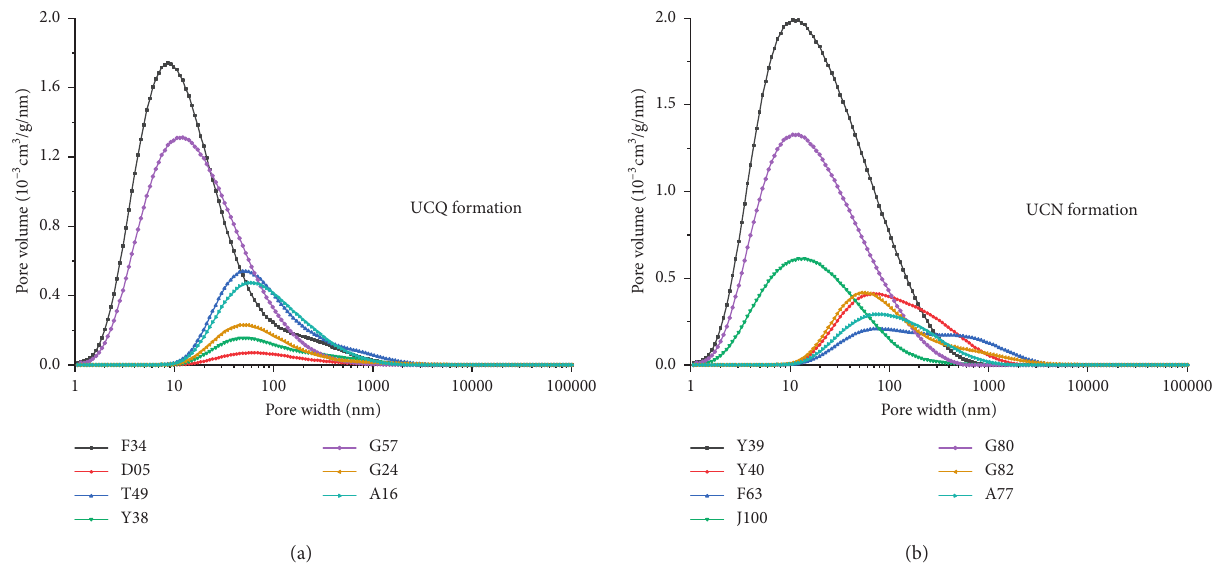
Figure 8: Pore size distribution based on low-temperature N NMR